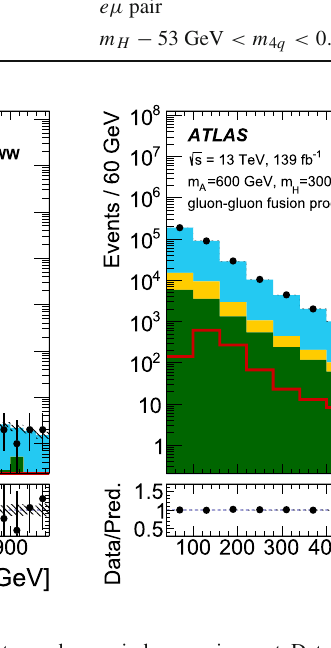
window requirement. Data-driven corrections are applied, as described in the text. The same conventions as in Fig. 4 are used